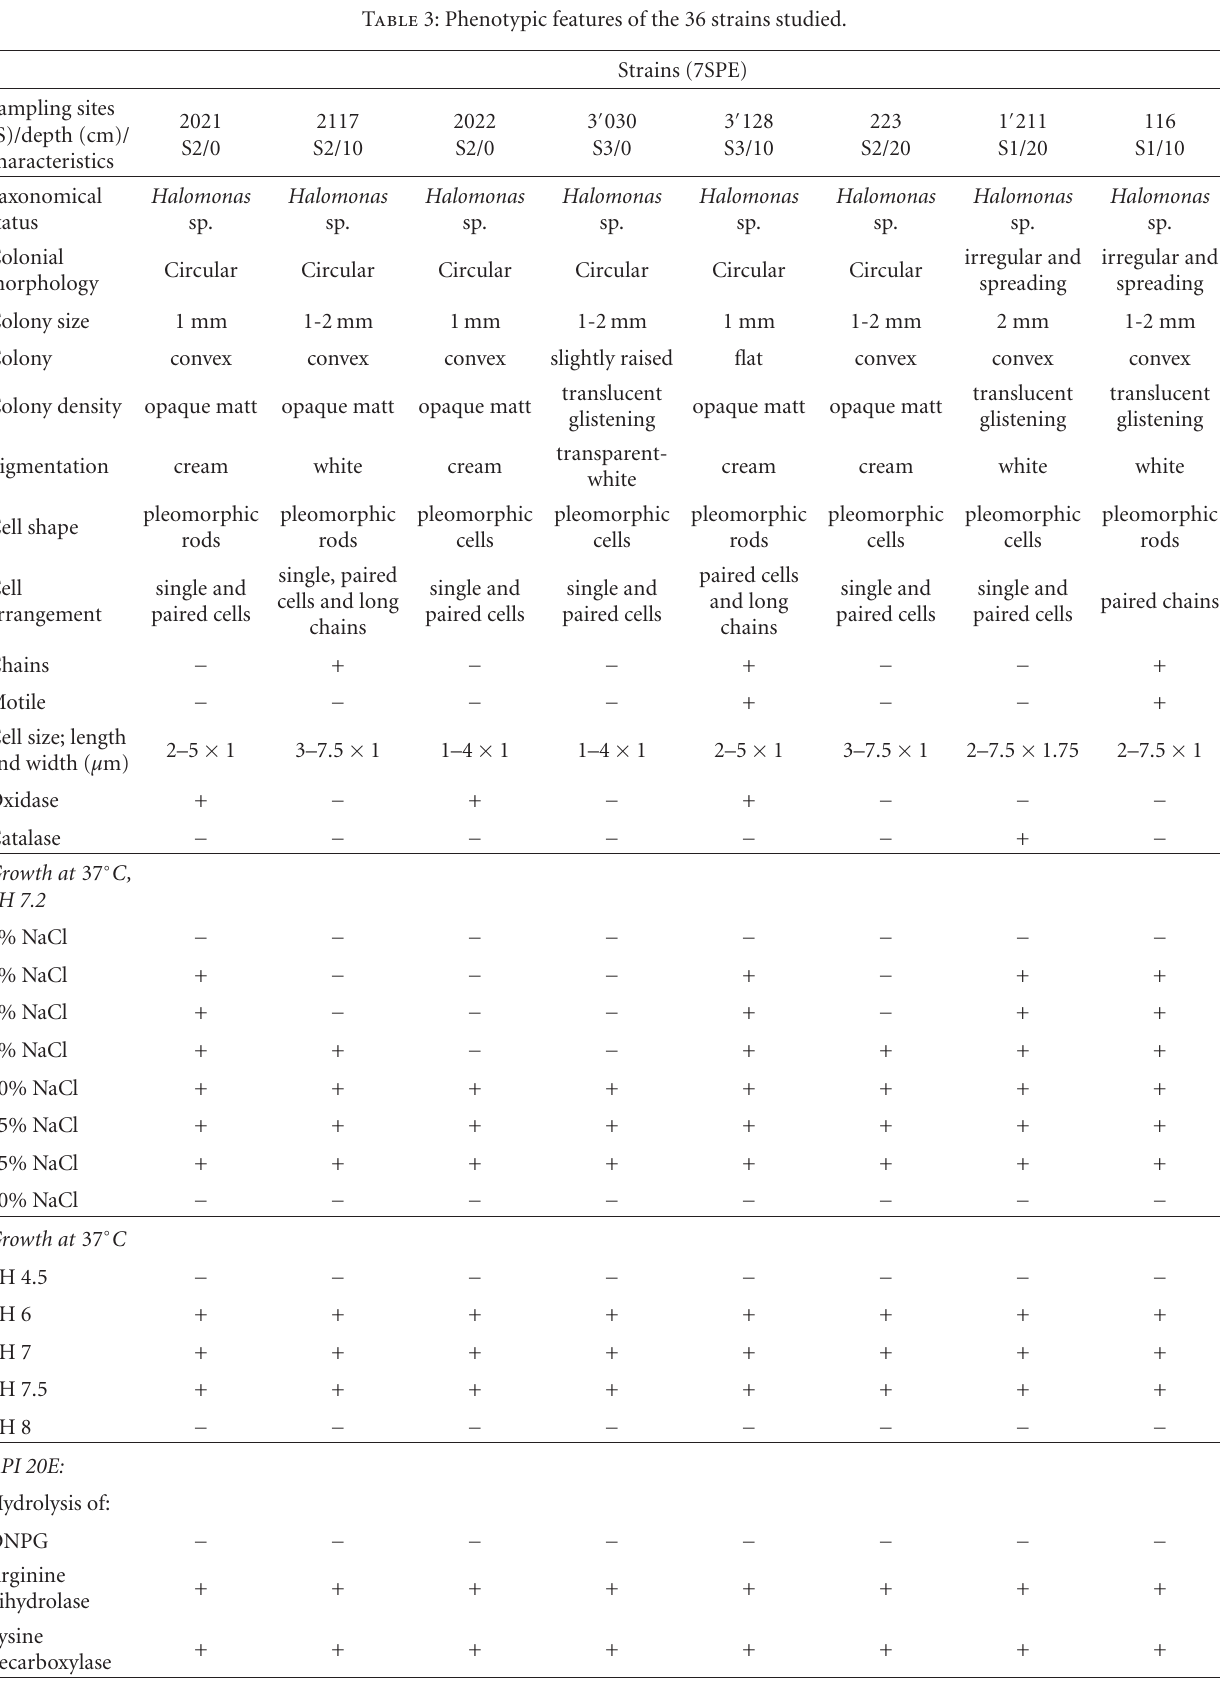
Table 3: Phenotypic features of the 36 strains